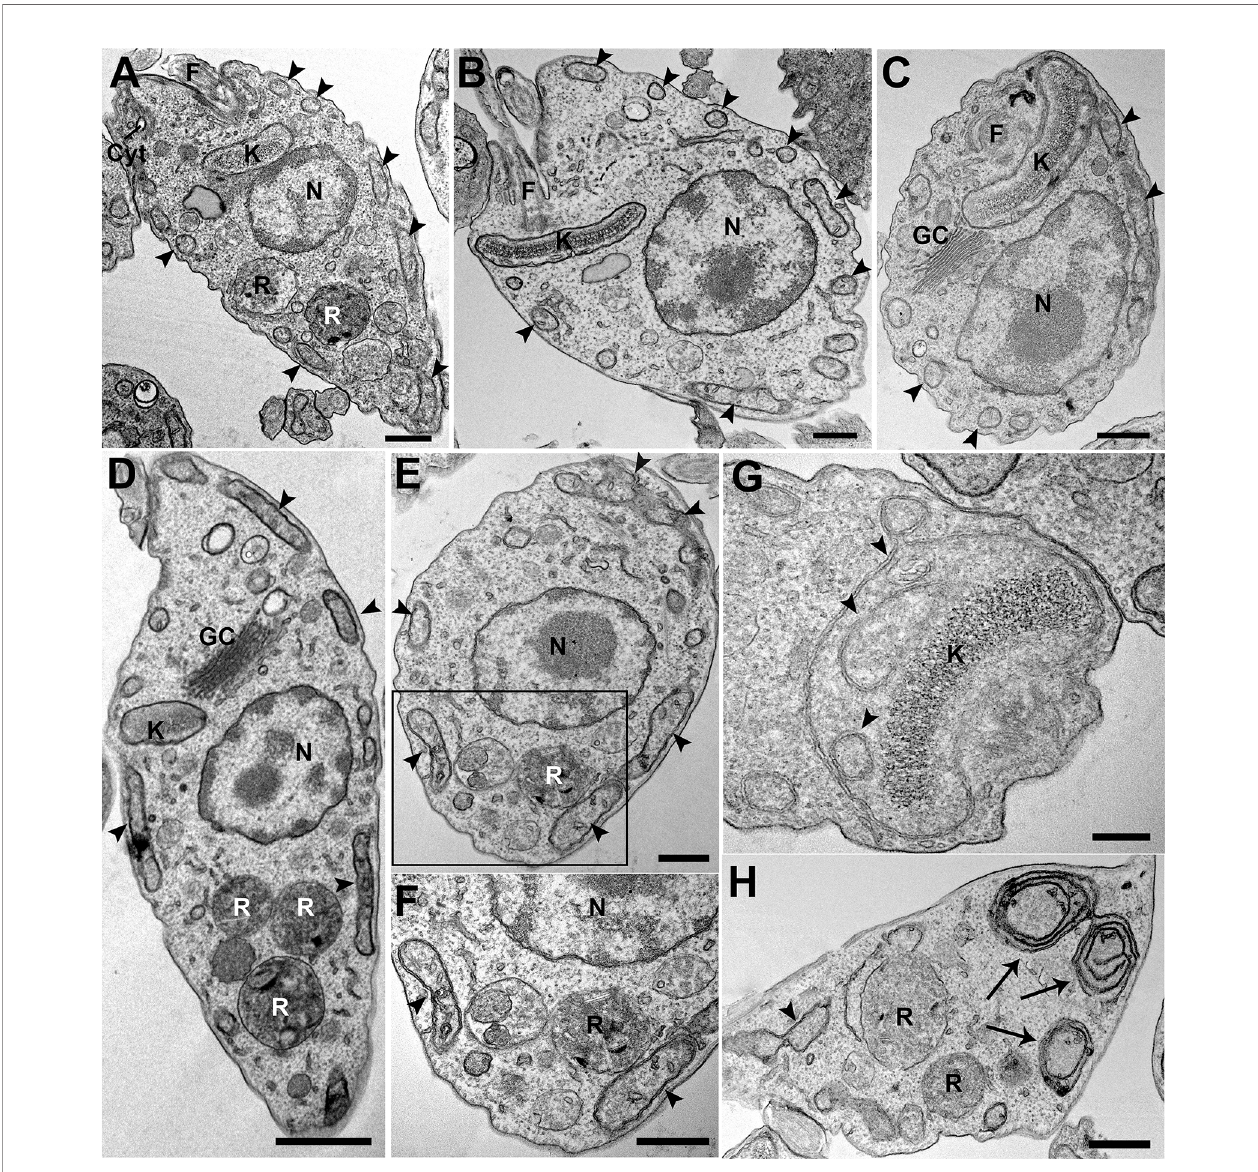
FIGURE 5 | Ultrastructural changes inTcIT-superexpressing parasites. pTEX-Ø andepimastigotes overexpressing TcIT were processedand observed by transmission electron microscopy. (A – C) Control pTEX-Ø epimastigotes show normal morphologyofmajor cellular organelles: kinetoplast (K),nucleus(N), Golgi complex (GC), cytostome – cytopharynxcomplex (Cyt),and reservosomes (R).Mitochondrial branches are seen allalongthe cellbody, juxtaposing the cell membrane (arrowheads). F ( fl agellum). (D – H) Epimastigotes overexpressing TcIT. (D) Mutants also present normal organellemorphologyand positioning when compared with controls, exceptfor the mitochondria. (E) Swollen mitochondrial branches (arrowheads) are observed inoverexpressing parasites. (F) Increasedmagni fi cation of the area delimited by the rectangle in (E) shows an increase in mitochondrial cristae and inner membrane vesiculation (arrowheads). (G) Mitochondrial inner vesiculation was observed at the kinetoplast (K) region (arrowheads). (H) Areas of mitochondrial inner membrane disorganization were also observed (arrows). Bars: (A – C,E,F, H) 500 nm; (D) 1 µm; (G) 200